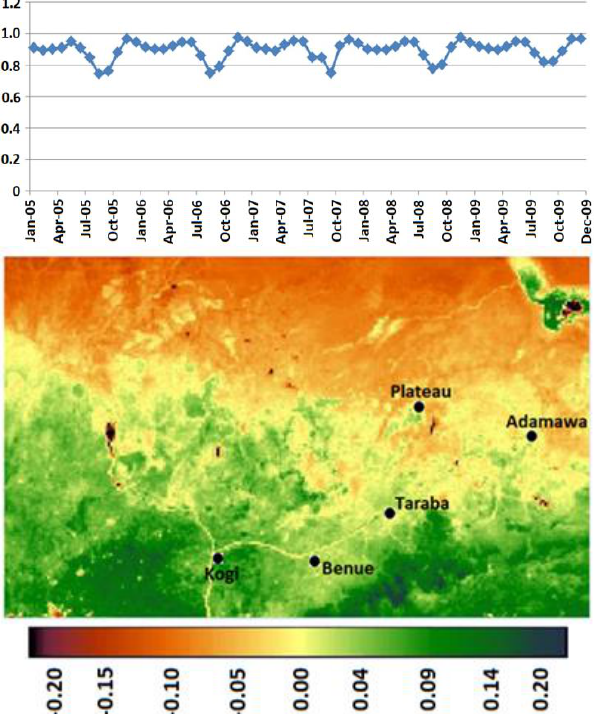
Figure 3. Component 1 image and its corresponding graph of